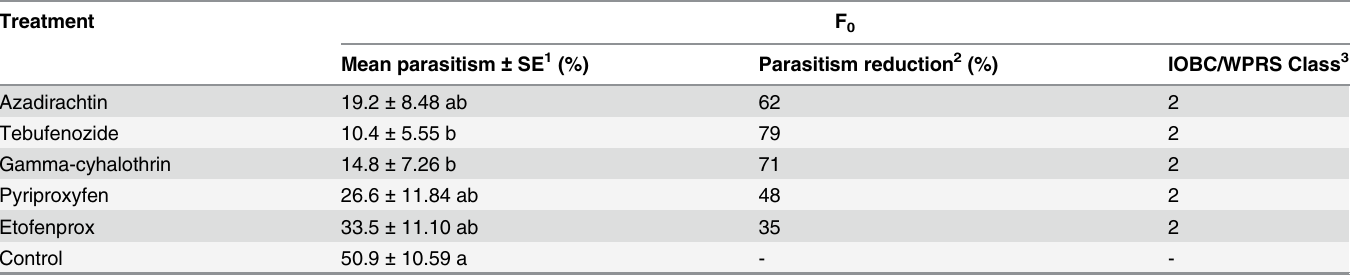
Table 4. Mean parasitism (%), reduced parasitism of Tamarixia radiata adults exposed to residues of different insecticides, and toxicological class proposed by the IOBC/WPRS, under 25 ± 2°C, 70 ± 10% RH and photoperiod 14 L: 10 D h. Treatment